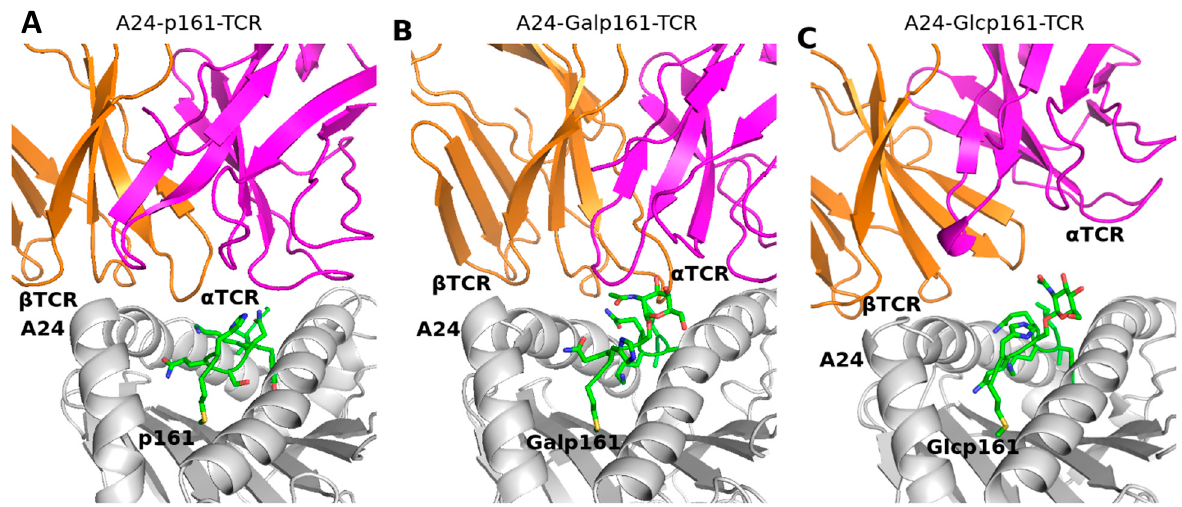
Figure 6. Snapshots taken from the MD simulations of ( A ) A24-p161-TCR, ( B ) A24-Galp161-TCR, and ( C ) A24-Glcp161-TCR complexes. A24, peptide, α - and β -chains of TCR are in grey, green, pink, and orange ribbons, respectively. The interaction residues are shown in sticks with Oxygen atoms in red and Nitrogen atoms in blue.